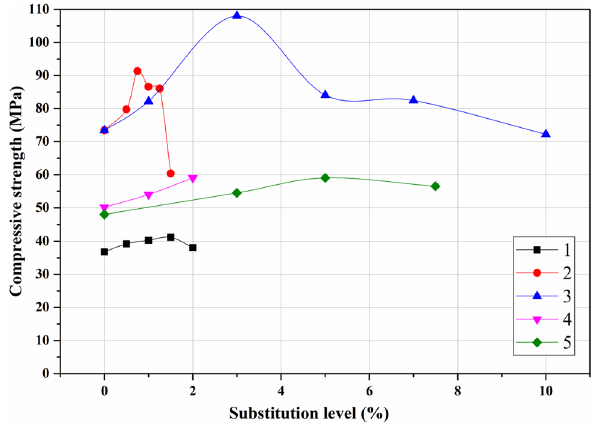
Fig. 4 Residual compressive strength with the substitution level of nanoparticles [47]